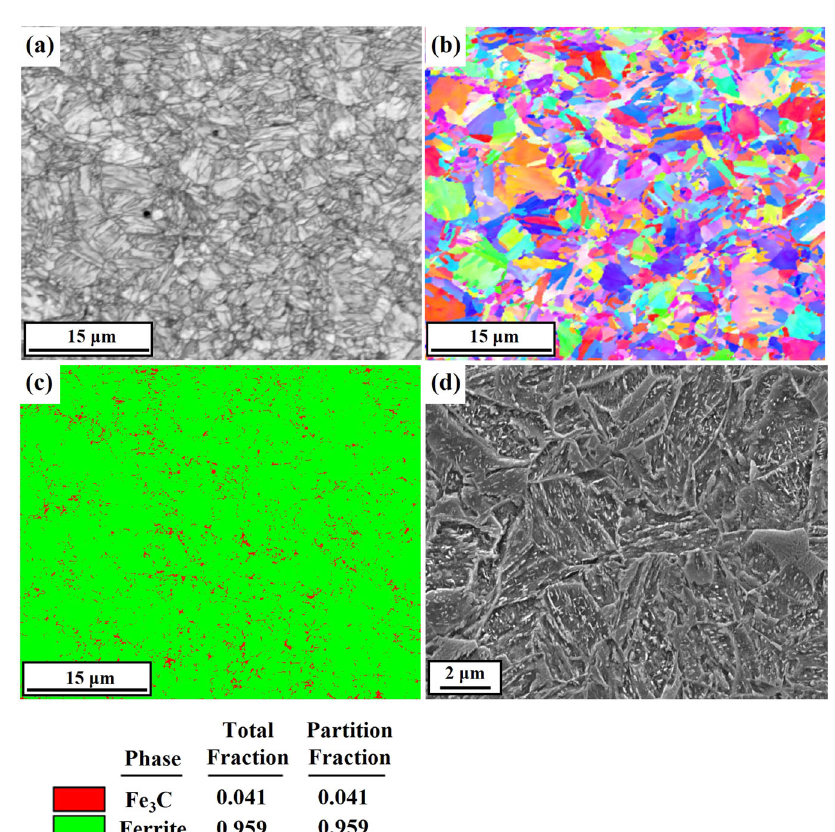
Fig. 1 Microstructural analysis of steel substrate. a – c EBSD image quality map, inverse pole fi gure map, and phase colored map, respectively. d FE-SEM